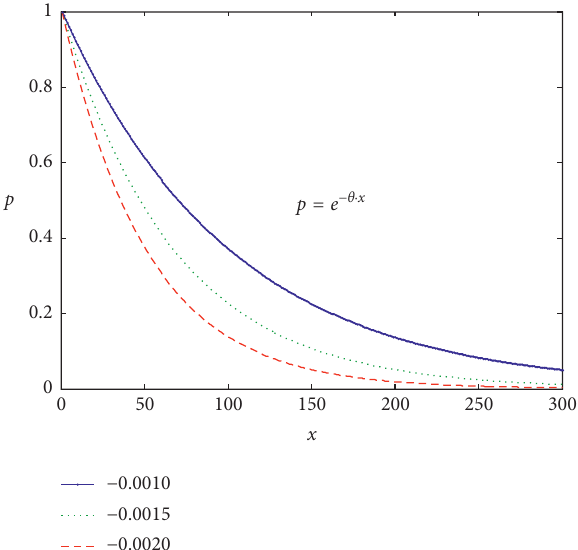
Figure 2: Variation tendency of the exponential function with the parameters.